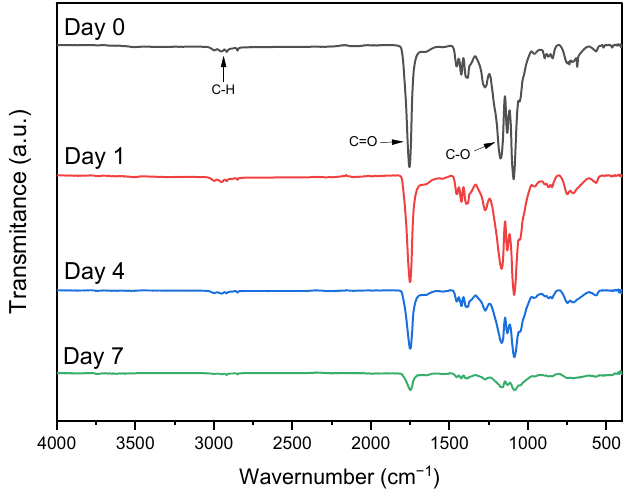
Figure 6. FTIR spectra of PLGA/collagen scaffolds until complete 7 days of degradation in collagenase.